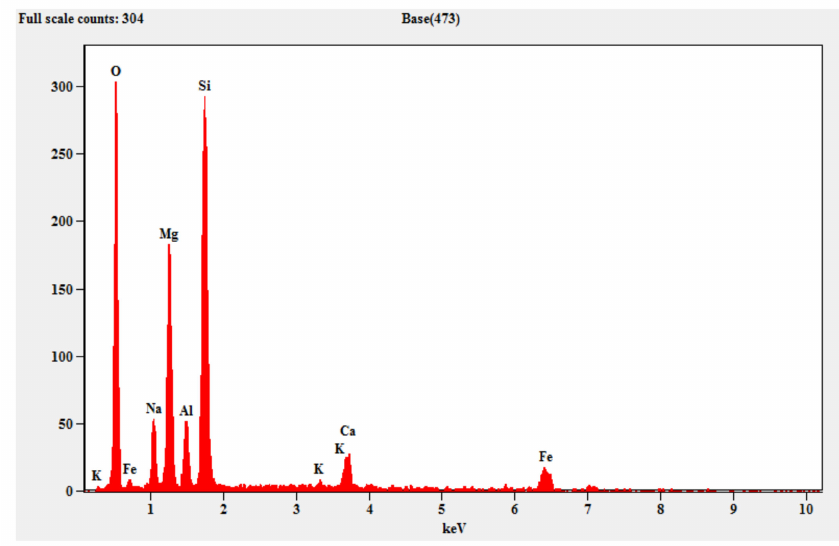
Figure 15. EDAX for optimized geopolymer mortar mix.